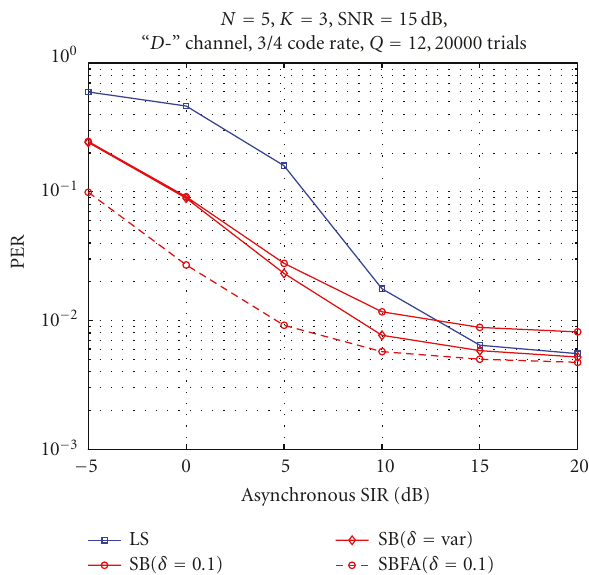
Figure 8: Typical PHY-layer OFDM performance for LS, SB, and